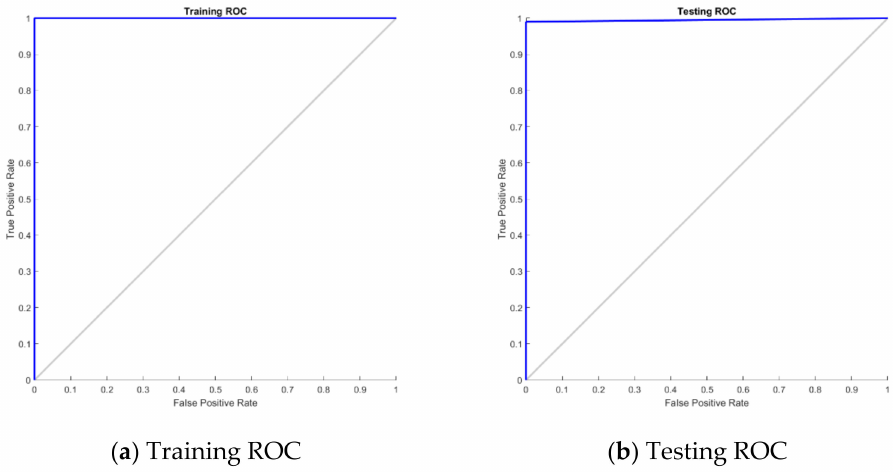
Figure 9. Training and testing ROC of the first stage of the proposed framework ( a ) ROC of the training of first stage; ( b ) ROC of the testing first stage of